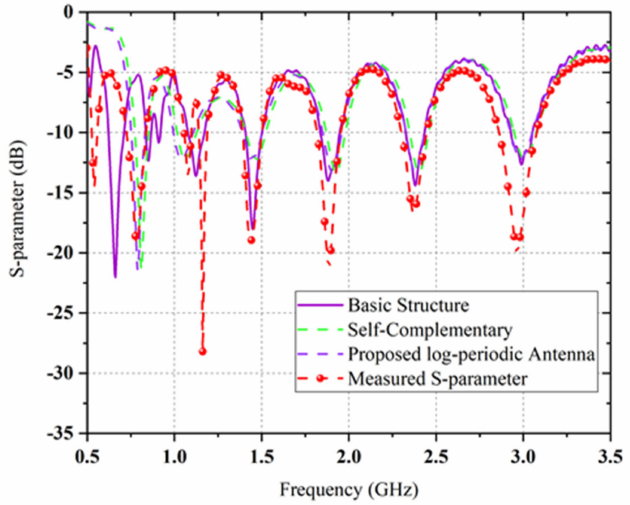
Figure 7. The comparison between simulated and measured scattering parameter (S11) of the proposed